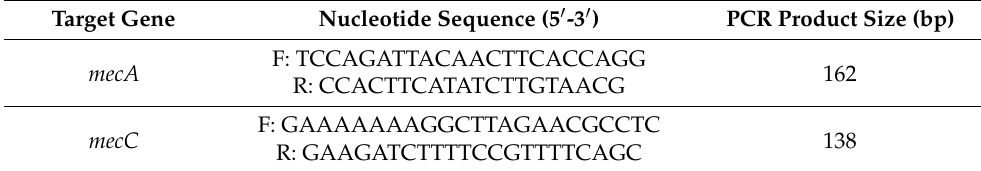
Table 1. PCR primers for mecA and mecC genes. Target